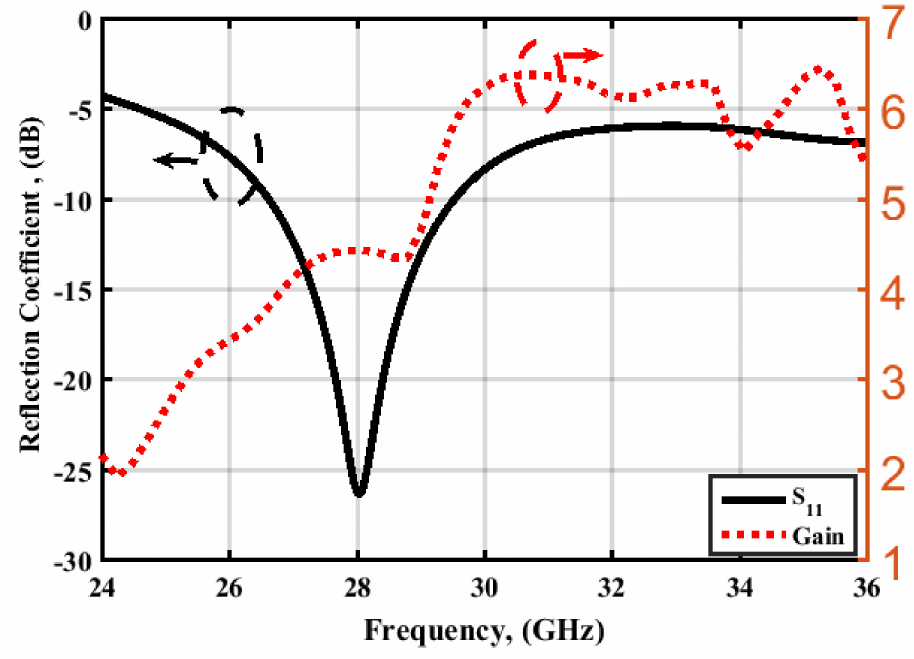
Figure 2. Reflection coefficient and gain characteristics of the single slotted